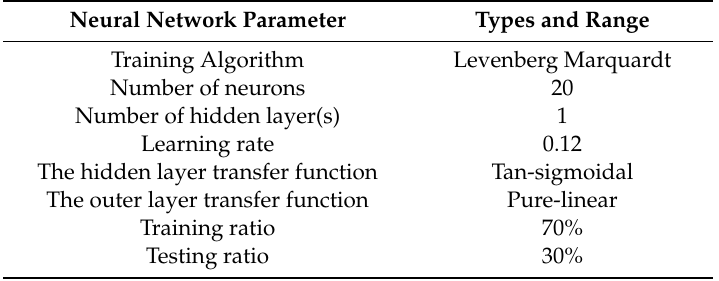
Table 3. Summary of the optimized parameters for the developed ANN